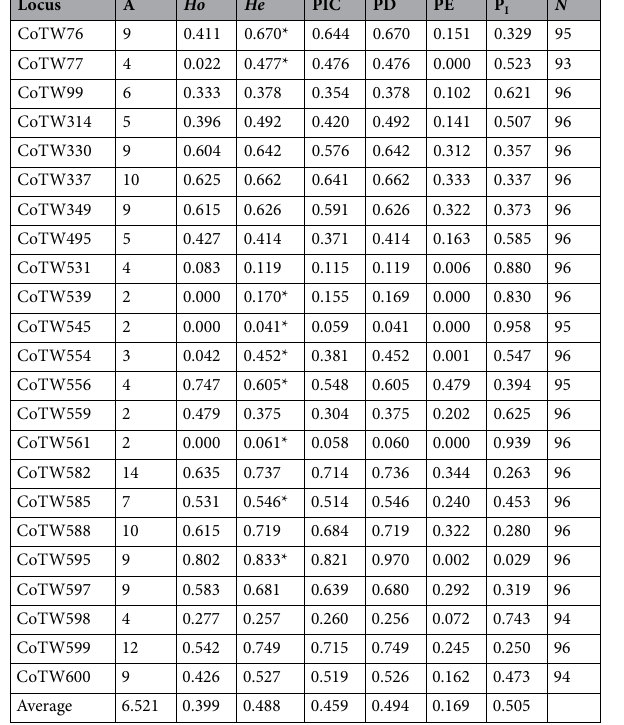
Table 3. Genetic characterization of 23 polymorphic gSSR loci of Chamaecyparis taiwanensis . A number of alleles, Ho observed heterozygosity, He expected heterozygosity, PIC polymorphism information content or power of information content, PD power of discrimination, PE power of exclusion or probability of exclusion, P I probability of identity, PD is equal to 1 − P I , N number of individuals. *Highly significant from Hardy– Weinberg equilibrium ( P < 0.001).